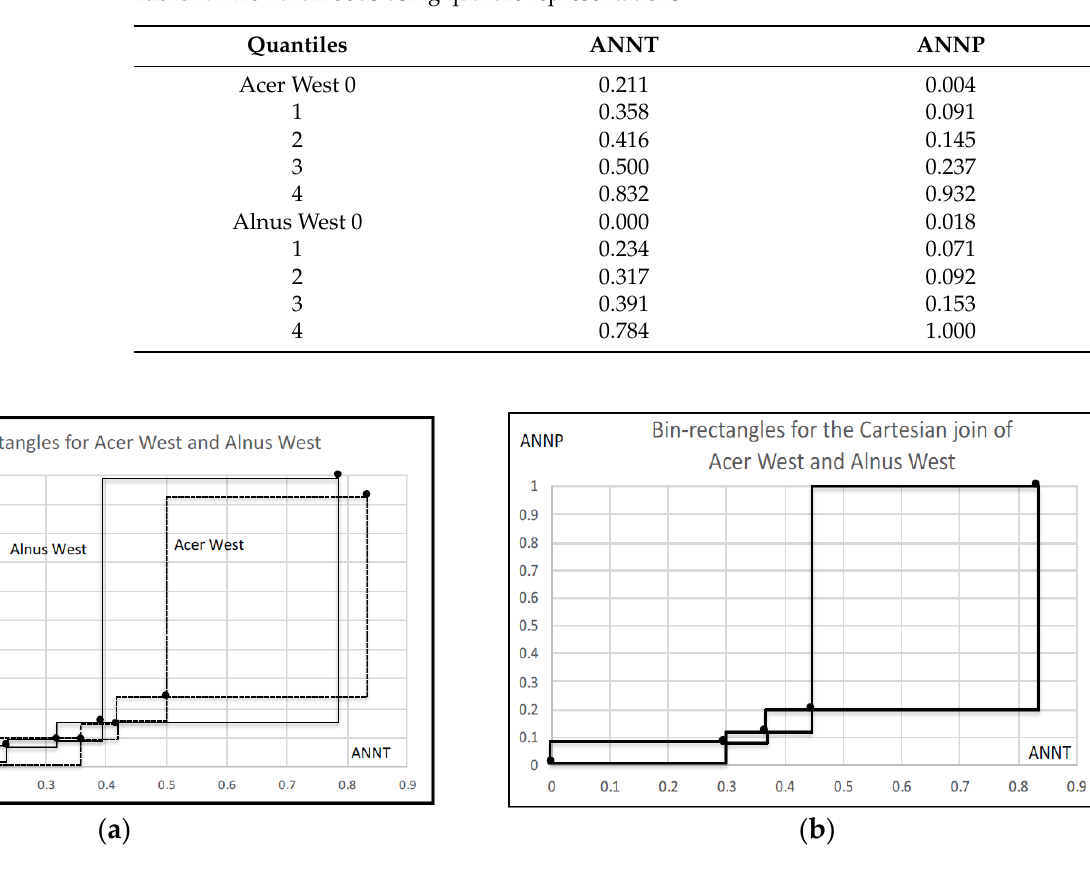
Table 1. Two hardwoods using quartile representations.